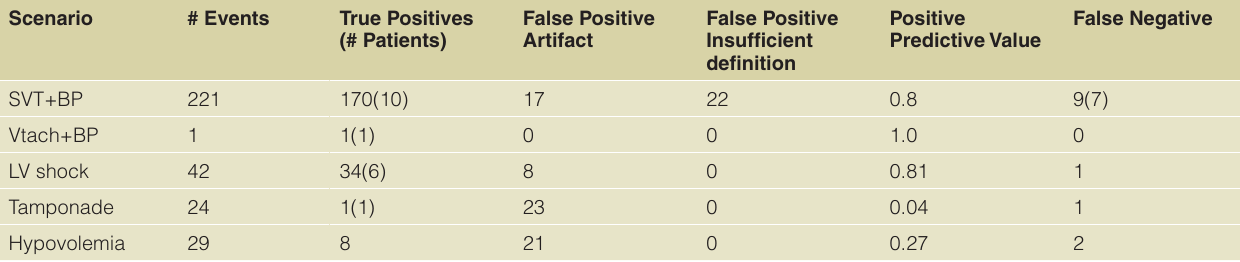
Table 3. Number of true positive, false positive and false negative events, together with the positive predictive value for each clinical alarm scenario using Event Surveillance software. Scenario